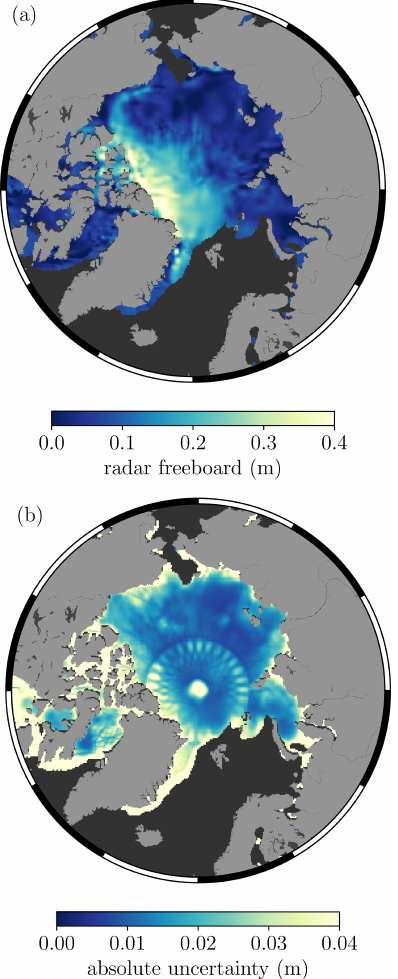
Figure 3. (a) Gridded CS2S3 radar freeboard from Gaussian pro- cess regression. (b) The absolute uncertainty (1 standard devia- tion), corresponding to the square root of the predictive variance from Eq. (5). Both images correspond to estimates on the 1 Decem- ber 2018, at a grid resolution of 25 ×